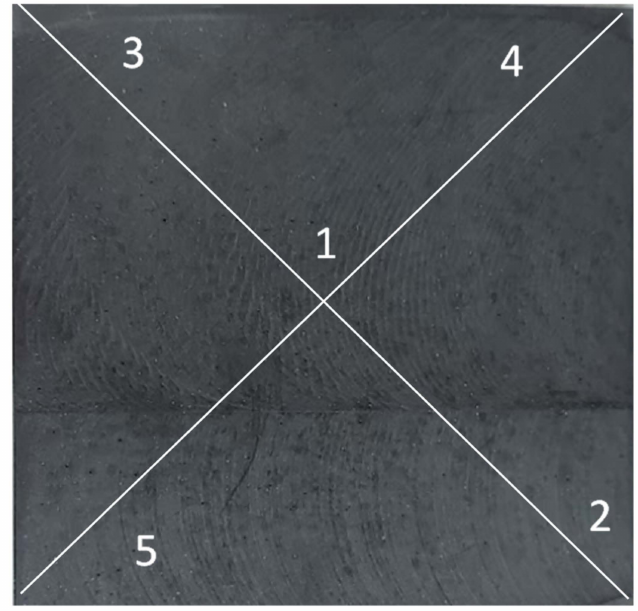
Figure 8. View of the sample prepared for